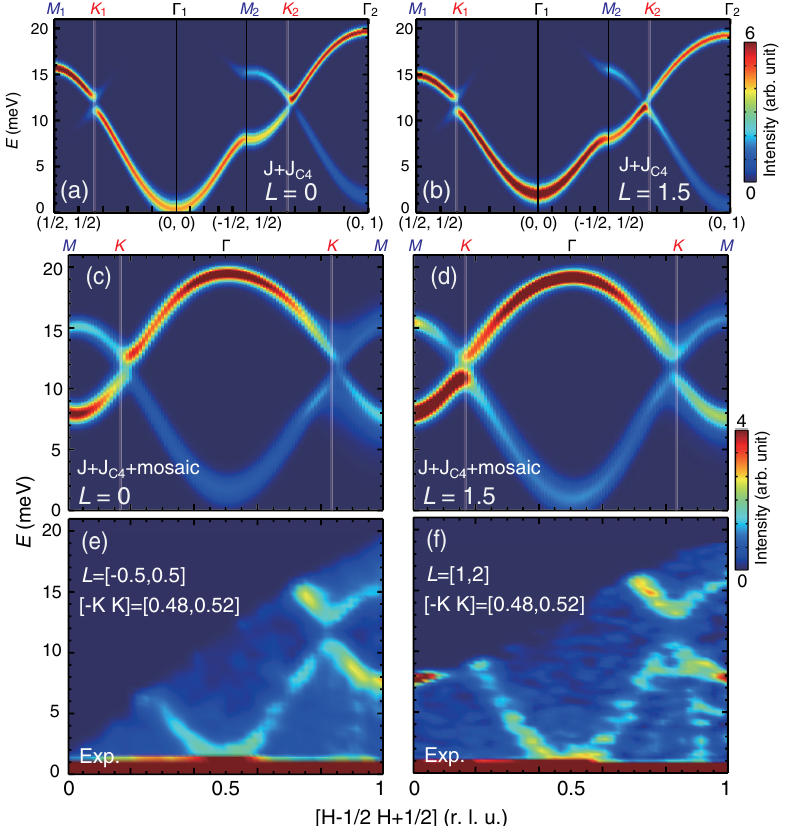
FIG. 4. The Heisenberg- J c 4 (spin correlation) model simulation of CrI 3 spin wave spectra, here J c 4 ¼ − J 0 c 4 ¼ − 0 . 10 meV. (a, b) In- plane spin excitation spectrum with L ¼ 0 and 1.5, respectively. (c, d) Spin excitation spectra along (c) ½ H − 1 = 2 ; H þ 1 = 2 ; 0 (cid:3) and (d) ½ H − 1 = 2 ; H þ 1 = 2 ; 1 . 5 (cid:3) directions, respectively. The integration and mosaic effects are considered in the plot. (e, f) Experimental data corresponding to (c) and (d), respectively. The integration range of (c – f) are specified in (e) and